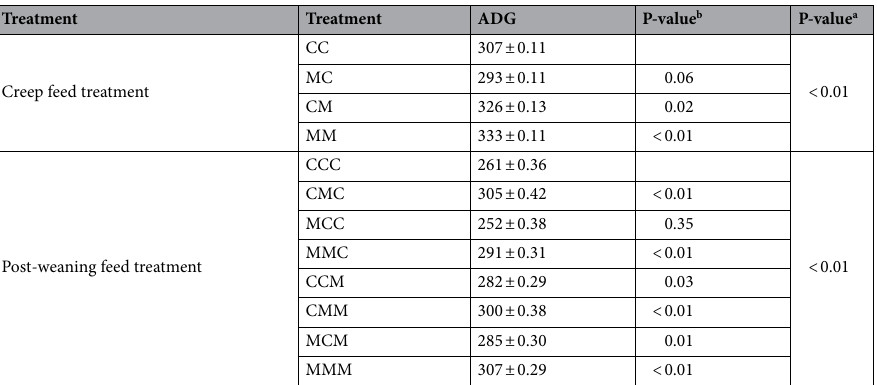
Table 1. Piglet growth at weaning and post-weaning. ADG average daily growth; MM sow MFC, piglets fed MFC creep feed; MC sow MFC, piglets fed control creep feed; CM sow control, piglets fed MFC creep feed; CC sow control, piglets fed control creep feed. MMM sow MFC, piglets fed MFC creep feed, post-weaning piglets MFC feed; MMC sow MFC, piglets fed MFC creep feed, post-weaning piglets control feed; MCM sow MFC, piglets fed control creep feed, post-weaning MFC feed; MCC sow MFC, piglets fed control creep feed, post- weaning control feed; CMM sow control feed, piglets fed MFC creep feed, piglets post-weaning MFC feed;